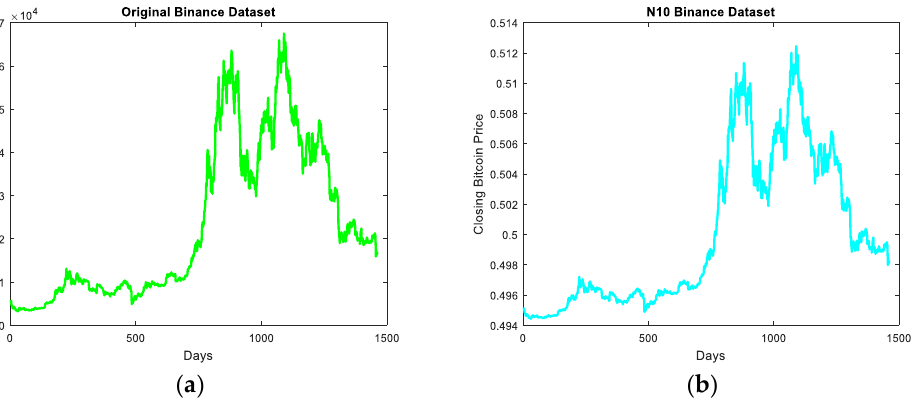
Figure 4. ( a ) Original Binance dataset of closing Bitcoin price in US dollars ( b ) Normalized Binance dataset using the proposed dual normalization.